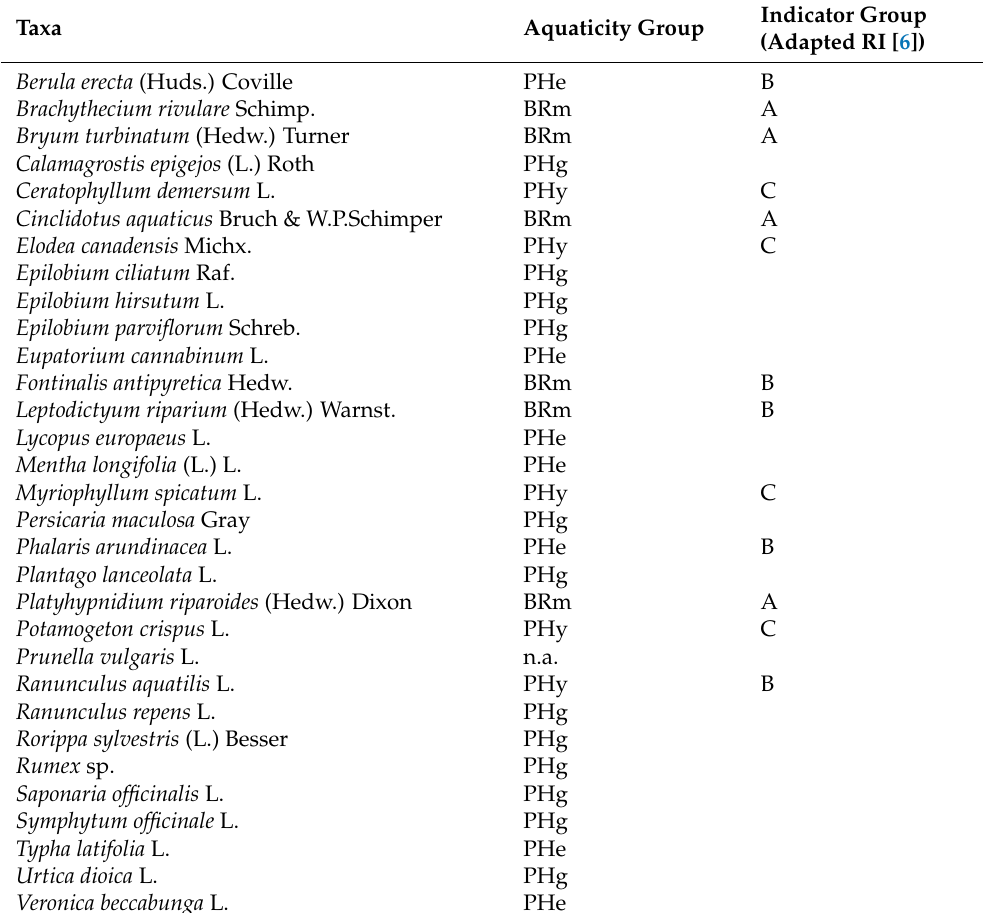
Table 2. List of the registered aquatic macrophytes and groups with regard to the link to the water after Birk et al. [13]. Legend: BRm—mosses; PHe—helophytes; PHg—hygrophytes; PHy—hydrophytes.